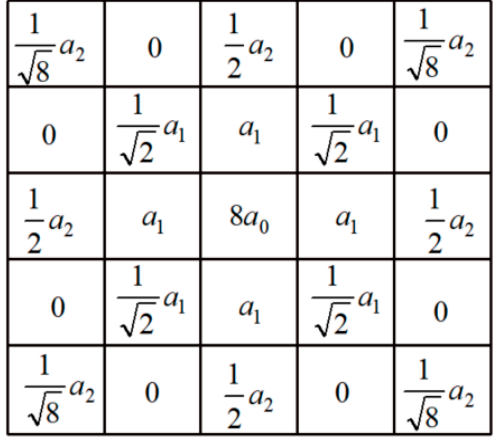
Figure 4. Fractional order weighted mask.